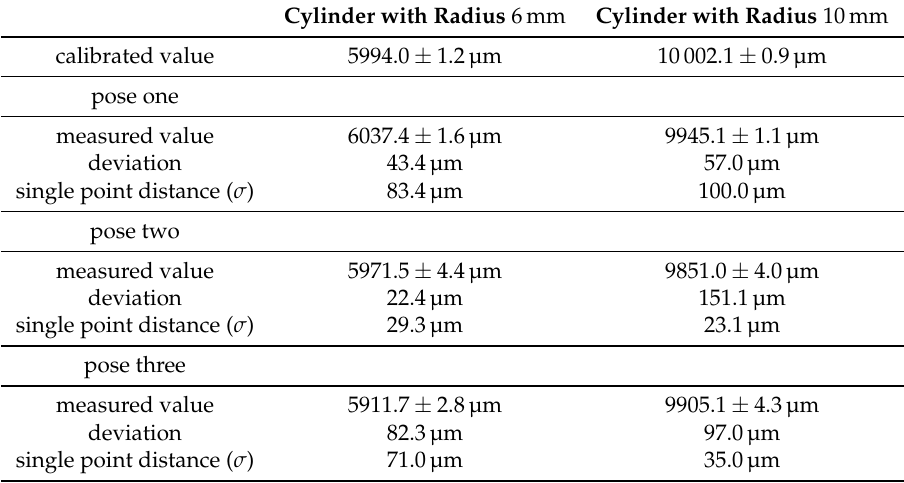
Table 2. Evaluation of two cylinders with a radius of 6mm and